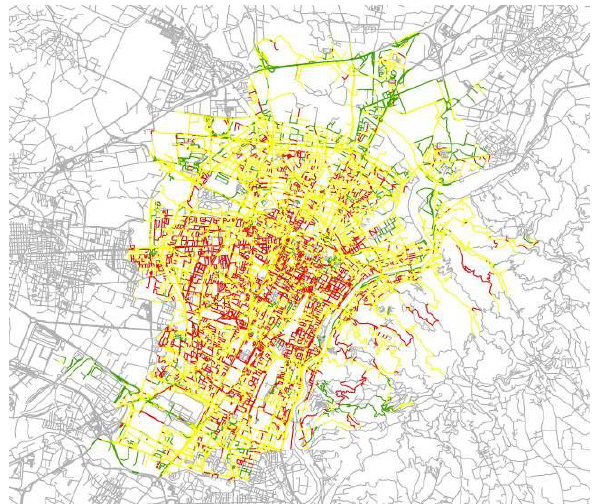
Figure 5. Mean HDOP value registered for each available FCD position and assigned to OTM road network elements (green = lower values and higher GPS signal quality, yellow = mean values and mean GPS signal quality, red = higher values and lower GPS signal